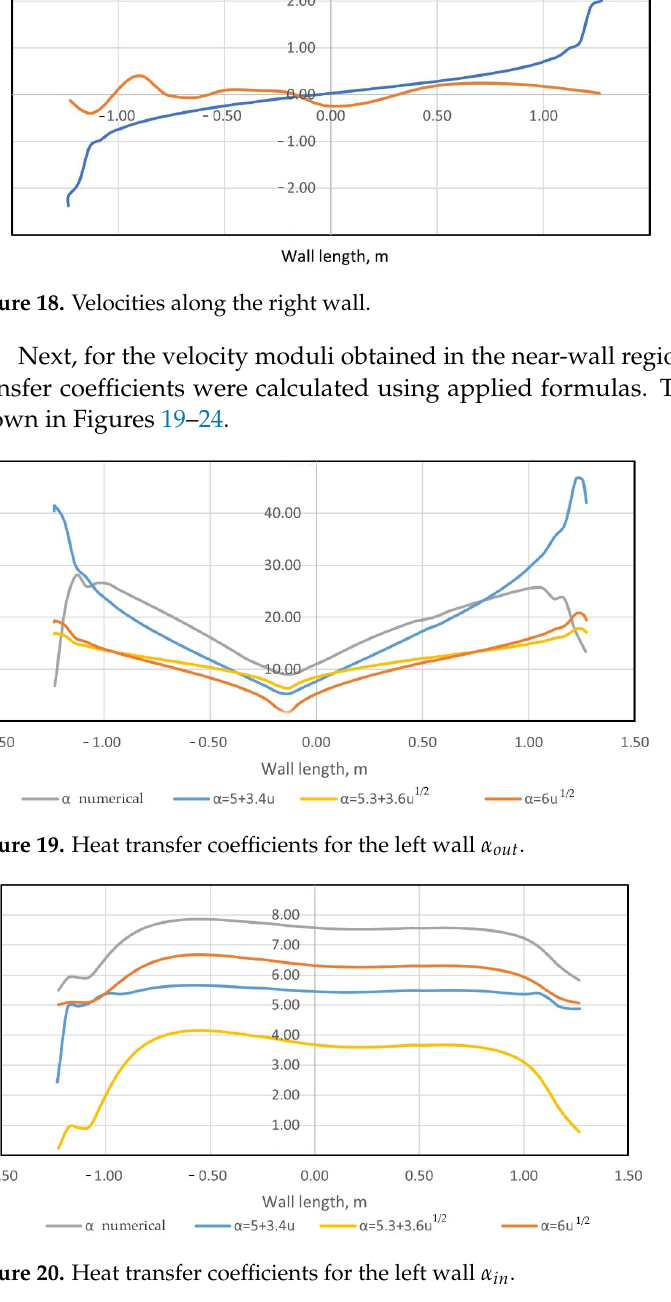
Figure 20. Heat transfer coefficients for the left wall 𝛼 𝑖𝑛 .